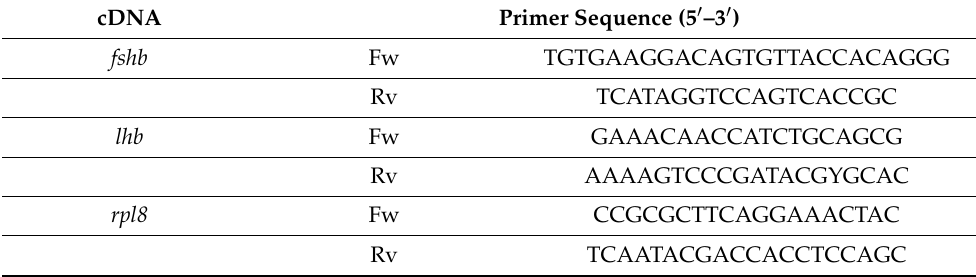
Table 1. Primer sequences used in quantitative real-time PCR.